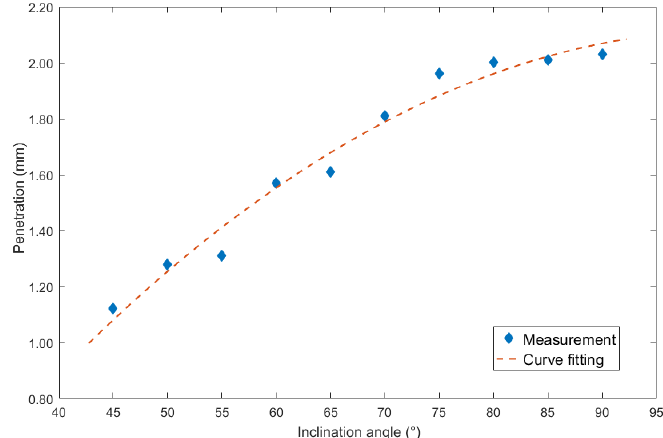
Figure 12. Curve fitting between backward inclination angle and penetration.